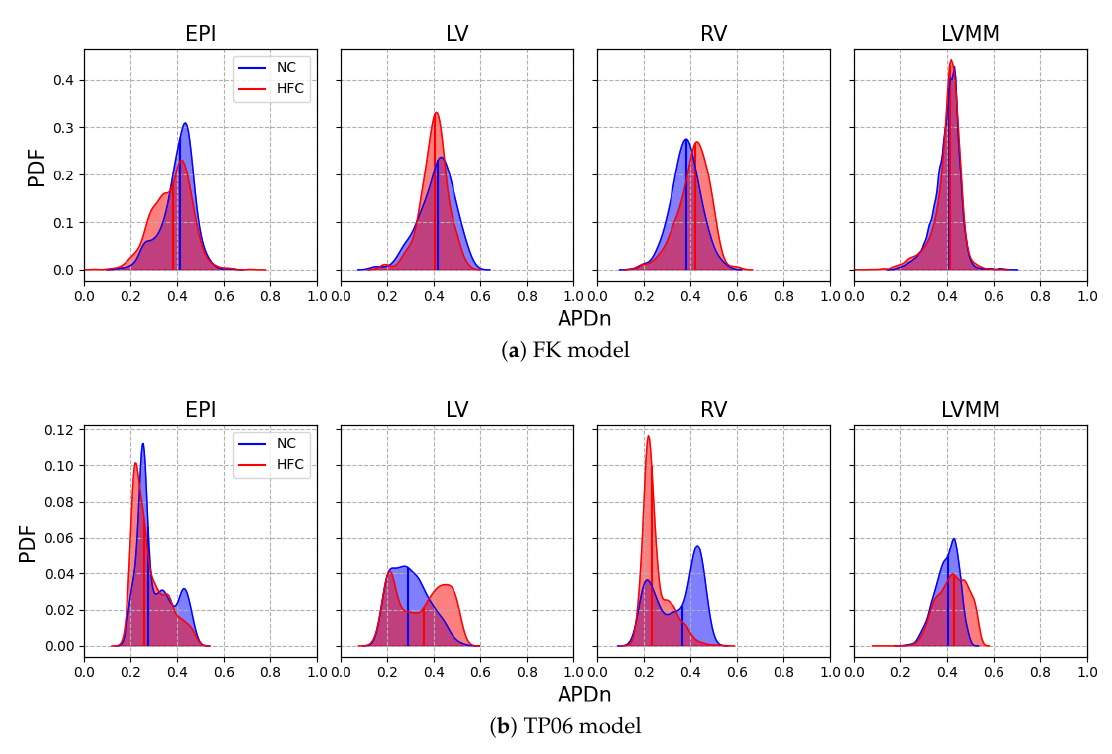
Figure 4. Normalized probability distribution function of normalized action potential duration at cycle length (CL) = 400 ms for ( a ) FK and ( b ) TP06 model, respectively. Blue and red traces refer to healthy (NC) and myocardyal infarction (HFC) cases, respectively. Median values are depicted with solid vertical